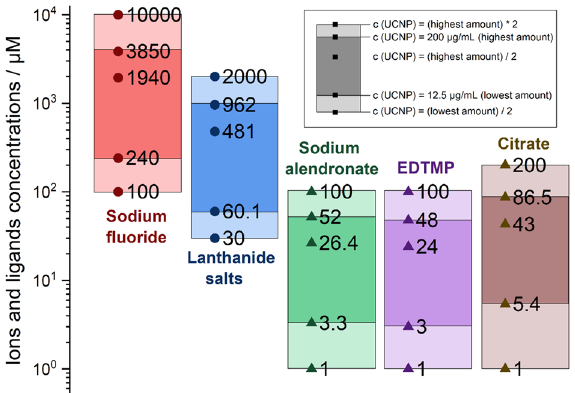
Figure 7. Concentration range of ions and ligands (µM) used for viability tests based on calculations of their total amount present in the lowest (12.5 µg/mL) and highest (200 µg/mL) concentration of UCNPs for the studied particles, assuming their complete release.